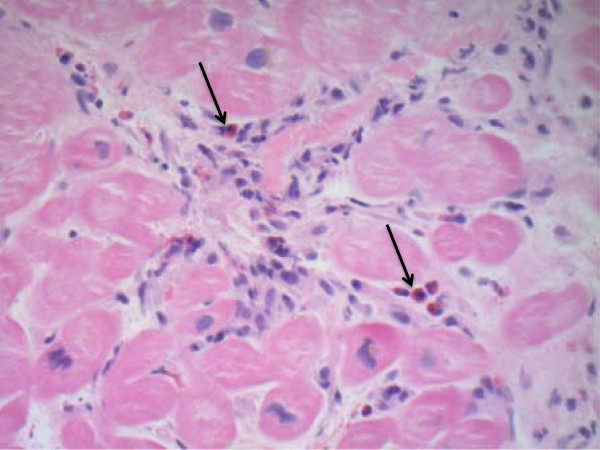
Endomyocardial biopsy of a patient with eosinophilic myocarditis (infiltrating eosinophils depicted by arrows).